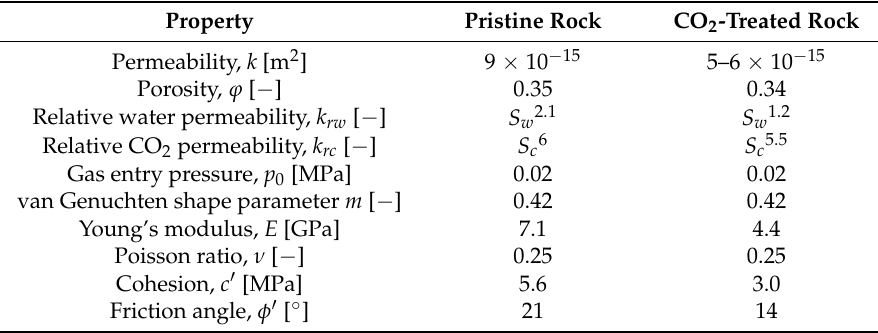
Figure 6. Failure envelopes for pristine and CO 2 treated Apulian limestone. Table 3. Properties of pristine and CO 2 treated Apulian limestone.